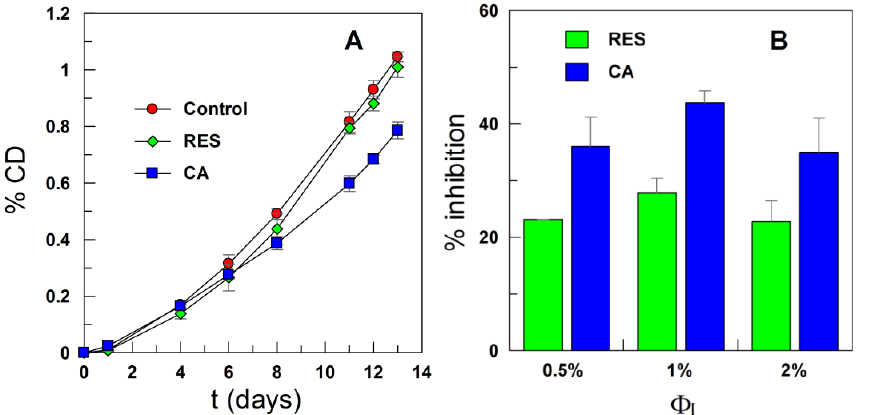
Figure 5. ( A ) Oxidative stability of stripped corn oil in water emulsions (4:6) obtained in the presence of RES and caffeic acid (CA) as determined by the change in the formation of conjugated dienes with the time at T = 55°C; and ( B ) inhibition by RES and CA on the formation of conjugated dienes in stripped corn oil emulsions during oxidation at T = 55 °C. Values were taken on Day 13. The percentage of inhibition was calculated as % Inhibition = [(C − S)/C] × 100, where C is the increment in the %CD (conjugated dienes) of the control and S is the increment in the %CD of emulsions in the presence of antioxidant (AO; [AO] = 0.6 mM in the corn oil and Φ = Tween 20